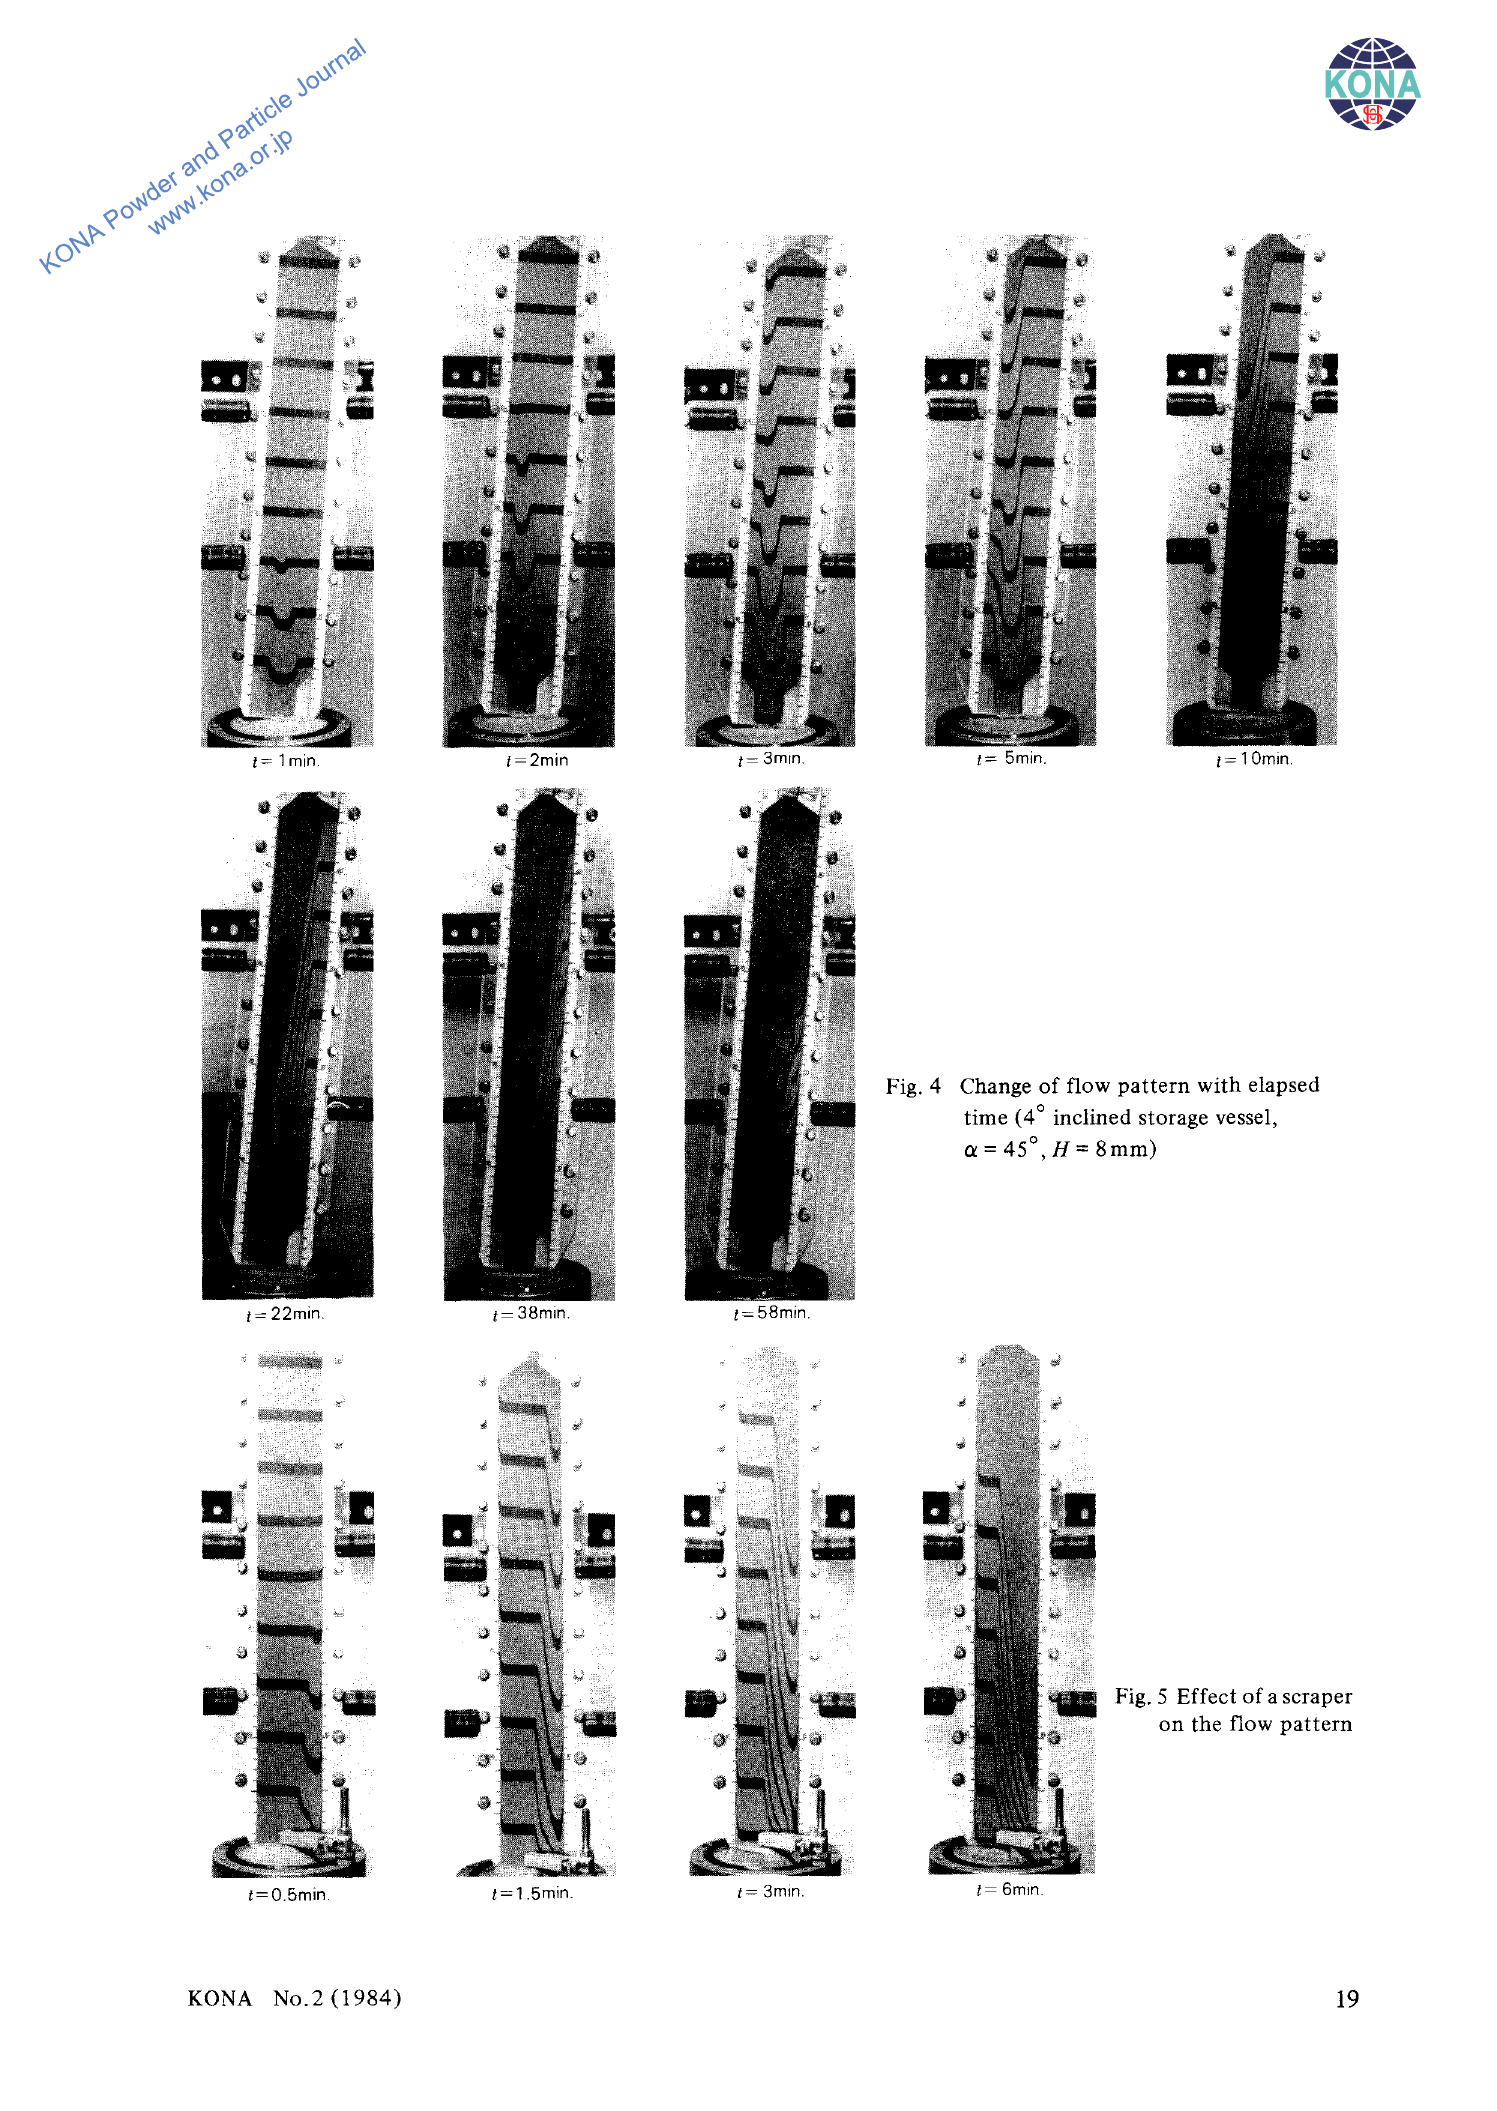
Fig. 5 Effect of a scraper on the flow